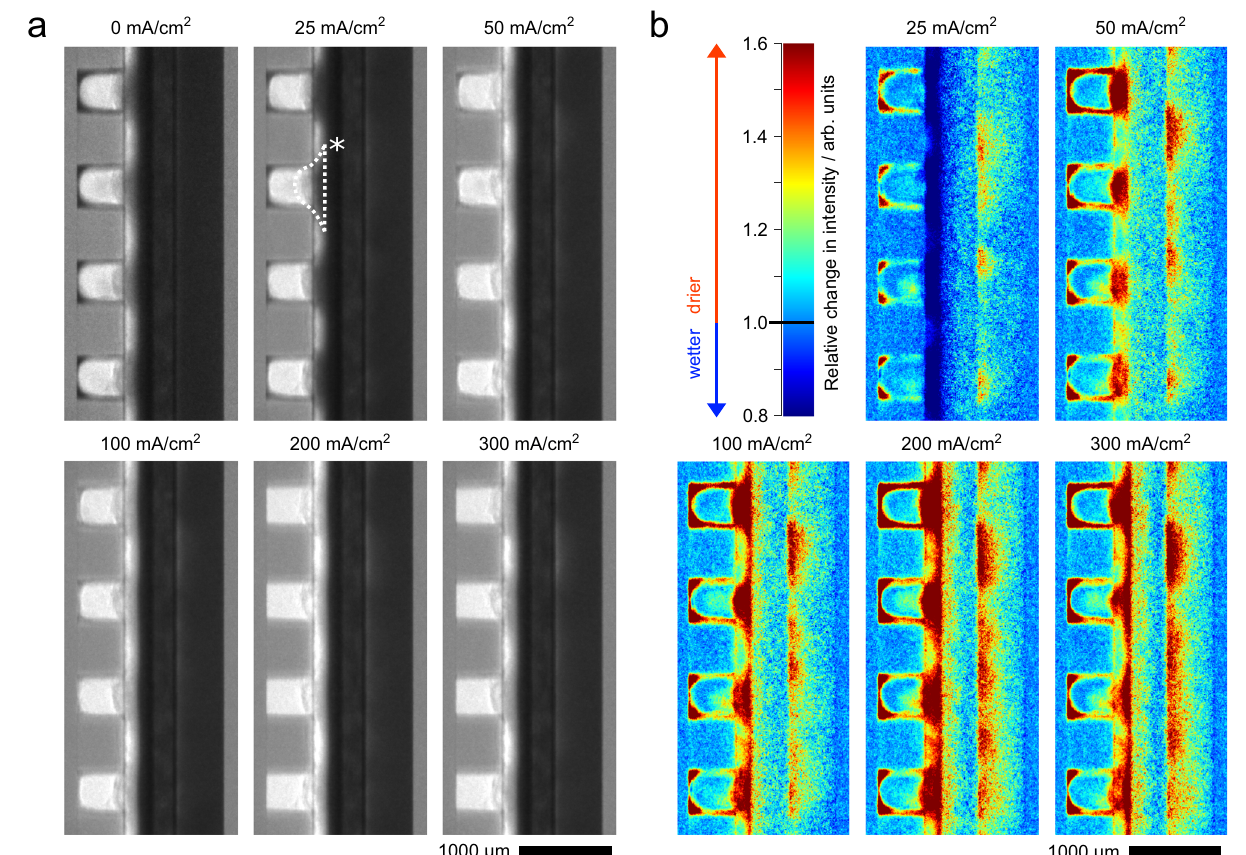
Fig. 3 | Neutron radiography of the CO 2 electrolysis cell. a Averaged neutron radiographic images at different current densities. * marks a dark area potentially